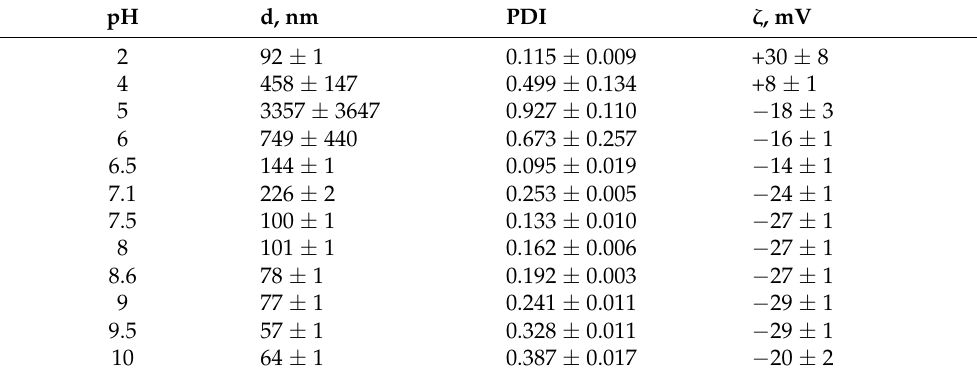
Figure 4. Emission spectra of SLNs (1 mg/mL) ( A ) and fluorescence intensity at 520 nm vs. pH ( B ). The size and zeta potential are expected to change with the pH of the medium (Table 2). Thus, at pH 2, colloid-stable particles with a positive zeta potential are formed, which can be achieved by protonation of xanthene fragments (the conjugated acid of methyl- substituted fluorescein’s pK is 1.94 ± 0.01 logarithmic units [28]). Protonation of triazole fragments at pH 2 seems unlikely since the pK of a conjugated acid of 1,4 disubstituted 1,2,3, triazole is 0.05 ± 0.01 logarithmic units [29]. Table 2. CAC values, and DLS and ELS data of SLNs at different pHs 1 .